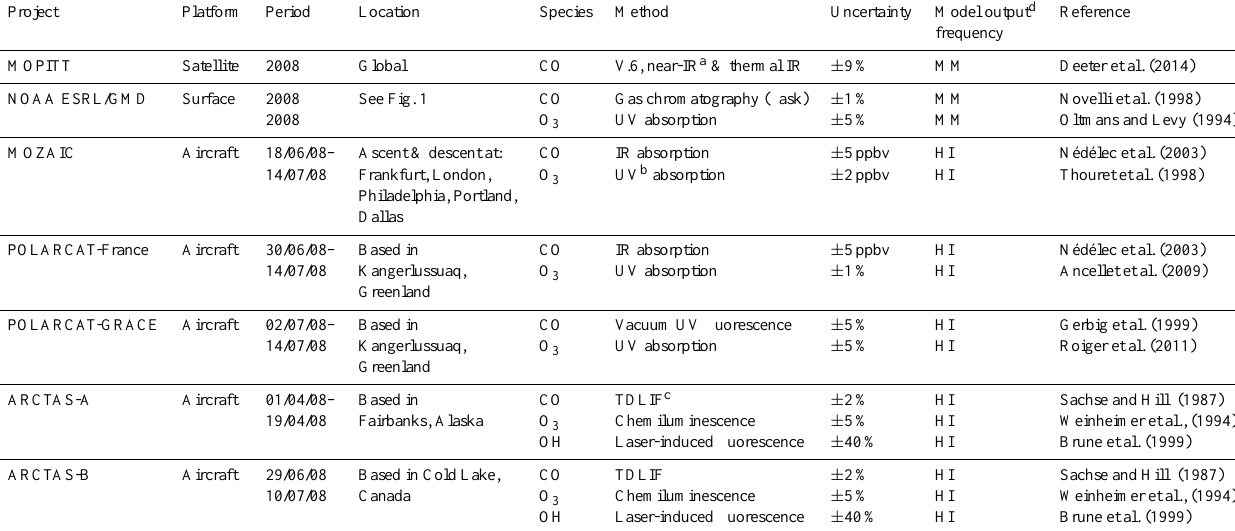
Table 2. Measurements used to evaluate the POLMIP